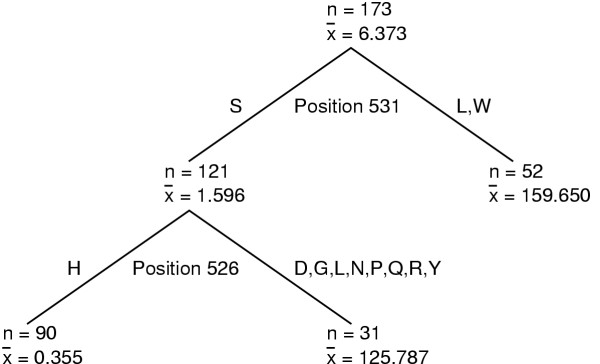
Cross-validated pruned regression tree for minimum inhibitory concentration (MIC) of rifampin (μg/ml) based on amino acid sequence data from positions 511–533 of the β subunit of RNA polymerase of Mycobacterium tuberculosis. The number of observations (n) and the mean MIC values across observations () are given for each node. Split definitions are depicted with amino acid positions represented by numerals and amino acids represented by single letter code adjacent branches.